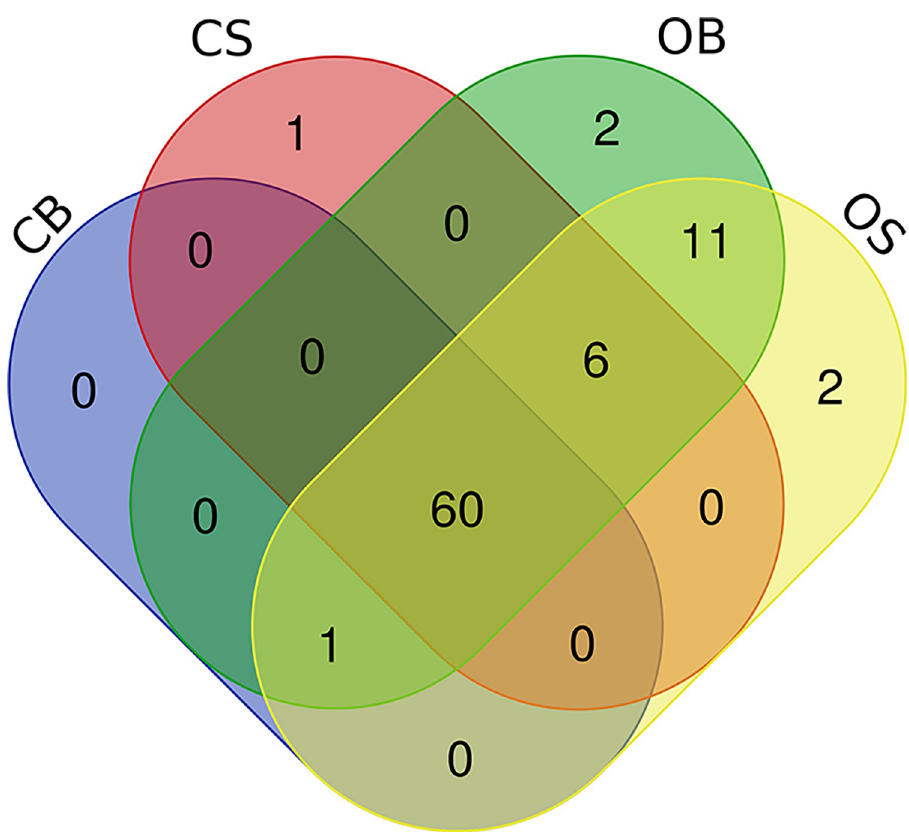
Fig 4. Venn diagram showing the number of core, differential and strain-specific carbon utilization of Burkholderia pseudomallei strains. The results obtained from the panels PM1 and PM2A are compiled in this schematic diagram.